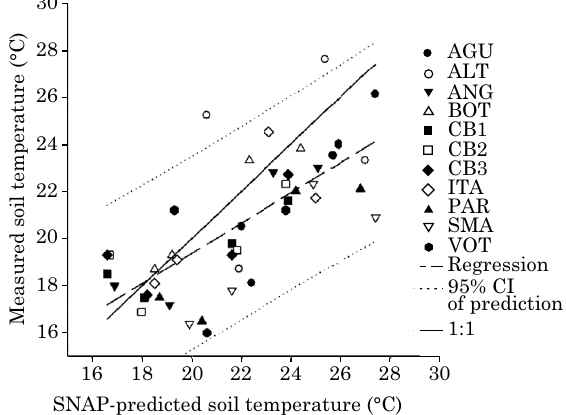
figure 1. soil temperature - measured (three-monthly) versus predicted value (three-monthly average of daily predictions) [ŷ = 6.57 + 0.640 x, R 2 = 0.51, model efficiency (ef) =